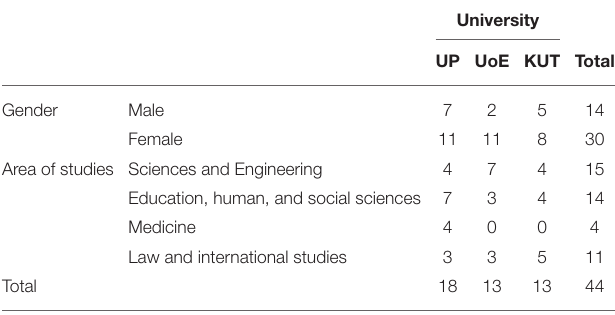
TABLE 1 | Focus groups